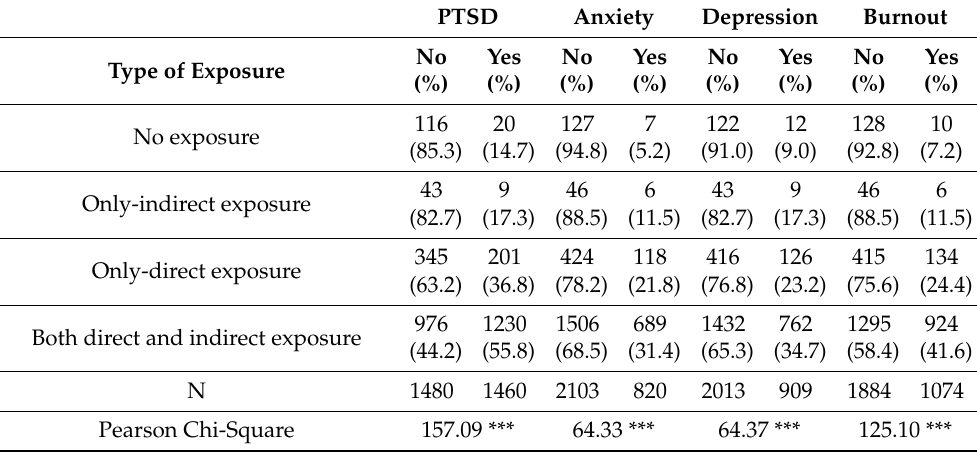
Table 2. Crosstab analysis of workplace violence exposure type by mental health outcomes ( N = 2958). PTSD Anxiety Type of Exposure